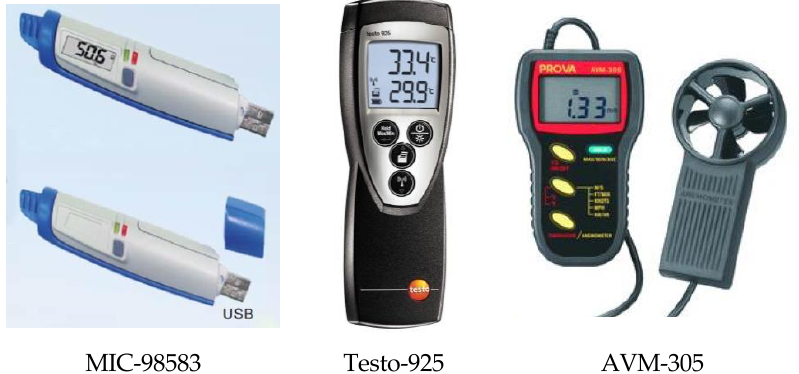
Figure 10. Sensors and data loggers used for the data collection.